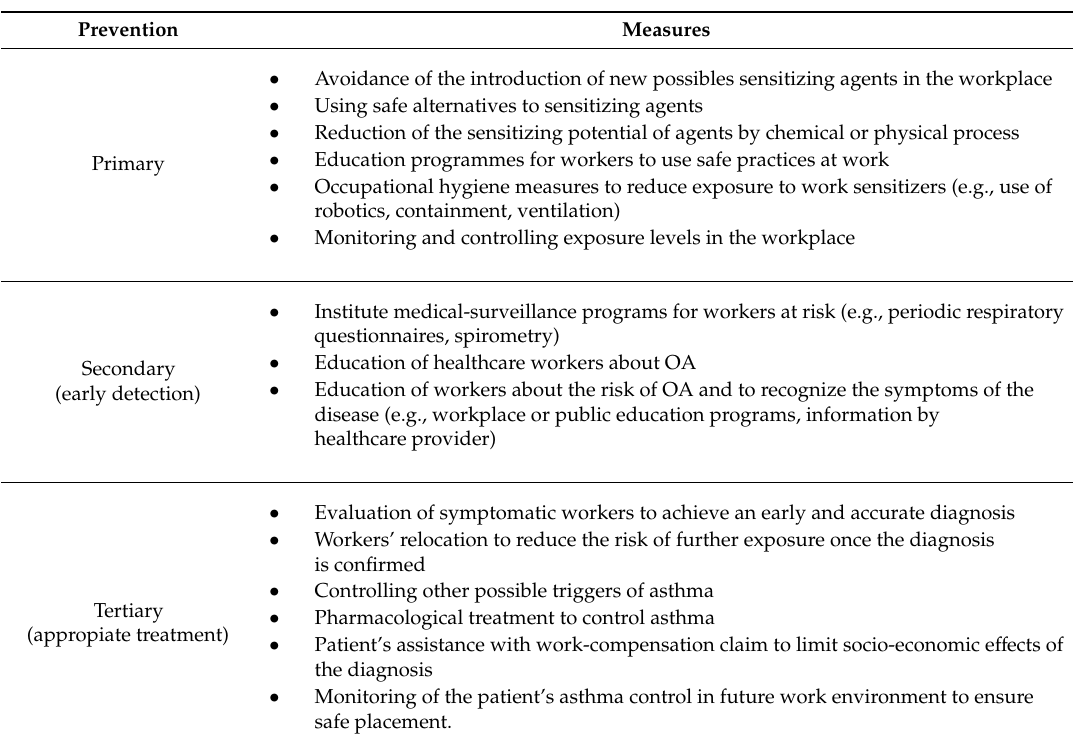
Table 1. Prevention of